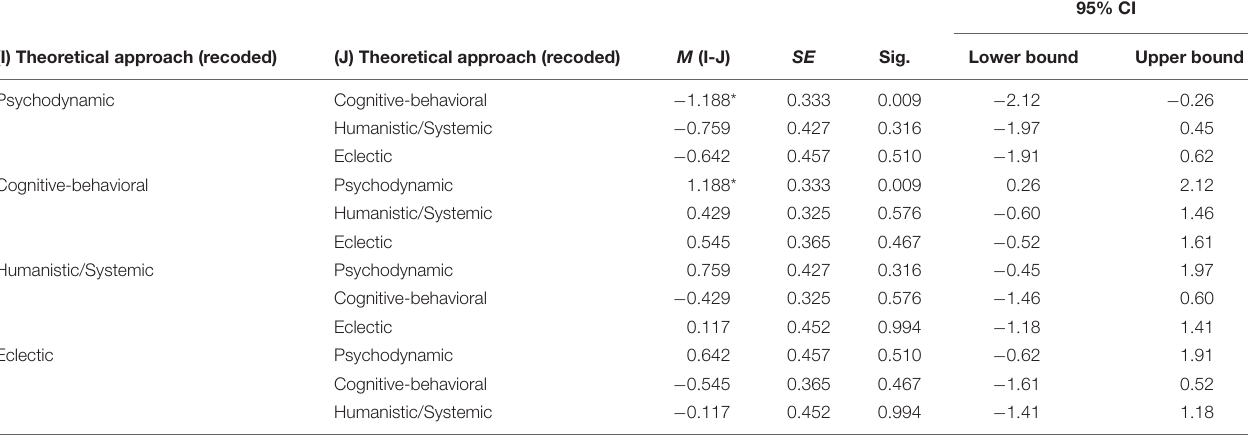
TABLE 3 | Games-Howell post hoc test for the variable “Directiveness and support” by theoretical approach.